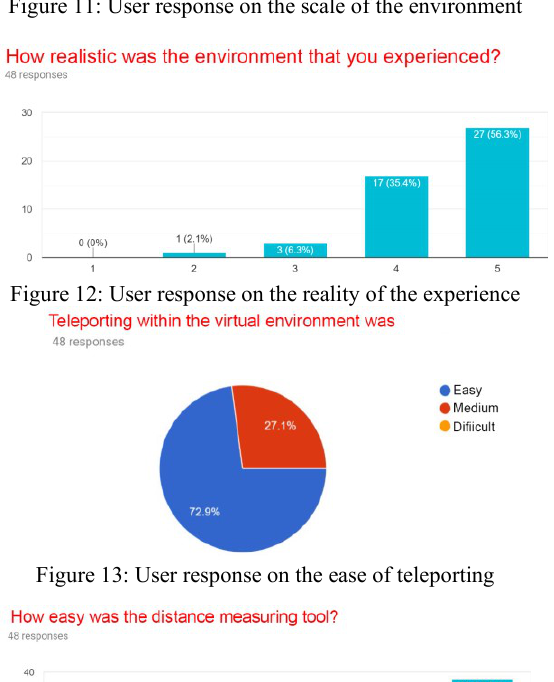
Figure 11: User response on the scale of the environment